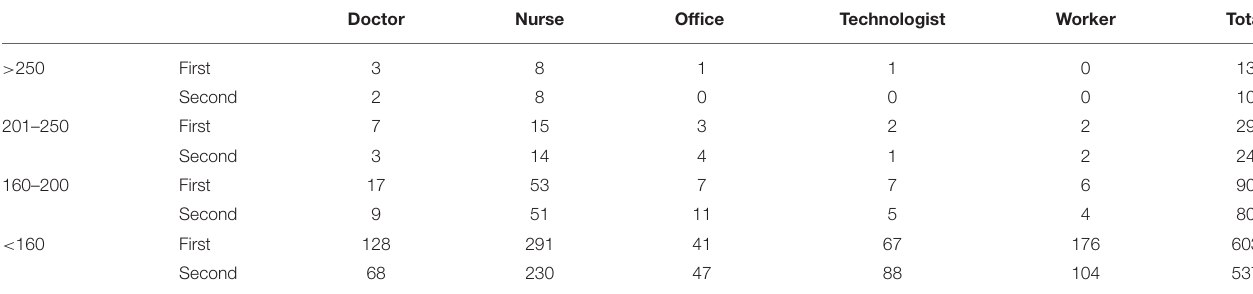
TABLE 5 | Total SCL-90 score distribution of healthcare professionals.